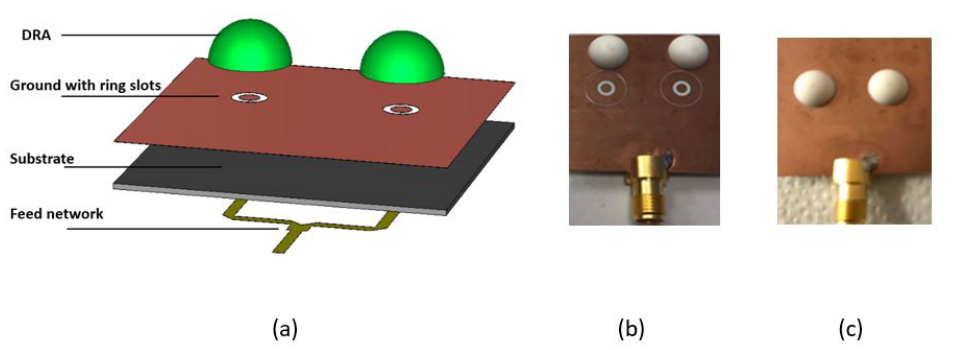
Figure 7. Configuration of the two hemispherical DRAs ( a ) 3D layout ( b ) outlined DRA positions ( c ) Assembled